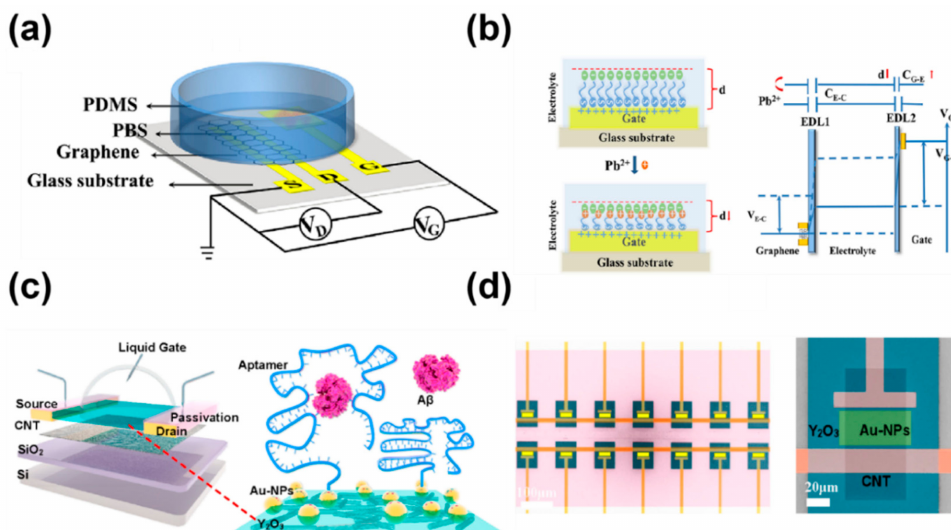
Figure 12. ( a ) Sensor construction diagram. ( b ) The change of current and voltage and the schematic diagram of potential after the sensor recognizes the lead ion. ( c ) Diagram of detection of serum samples by sensor based on OFET principle and diagram of hybridization of modified probe with polypeptide. ( d ) The scanning image of sensor prepared based on OFET principle under electron microscope. ( a ) Reproduced with permission [86]. Copyright 2021, American Chemical Society. ( b ) Reproduced with permission [86]. Copyright 2021, American Chemical Society. ( c ) Reproduced with permission [87]. Copyright 2022, American Chemical Society. ( d ) Reproduced with permis- sion [87]. Copyright 2022, American Chemical Society.